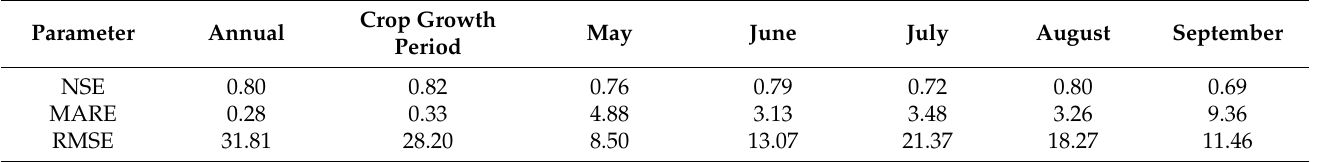
Table 3. Accuracy test of the MGSM at three time scales.